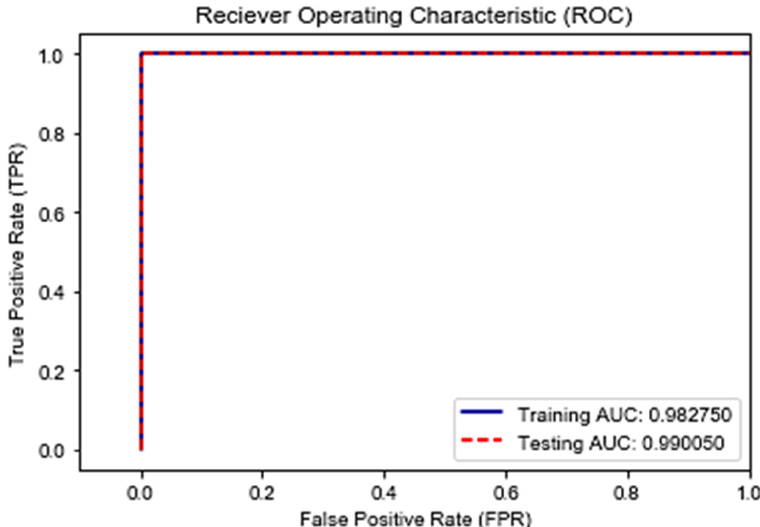
Figure 15. Proposed TweezBot AUC ROC Score.